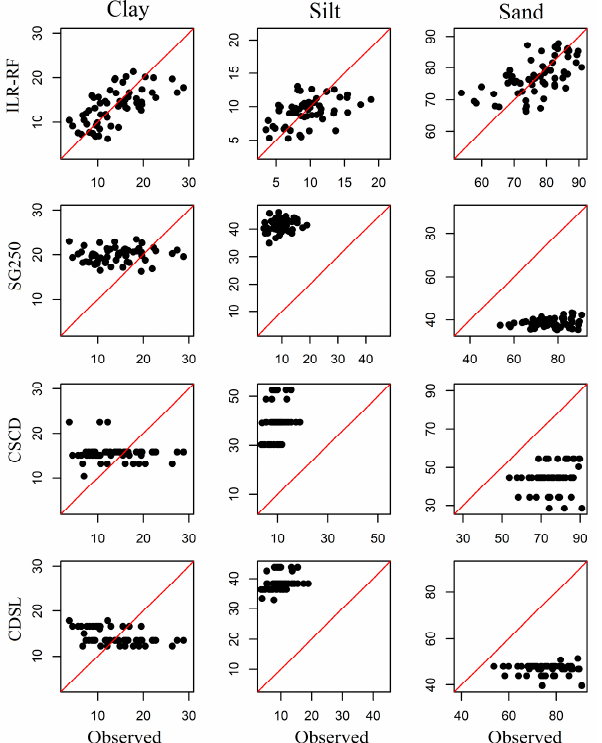
Figure 5. Comparison of soil particle size fractions at the Wenquan (WQ) region derived from four datasets.